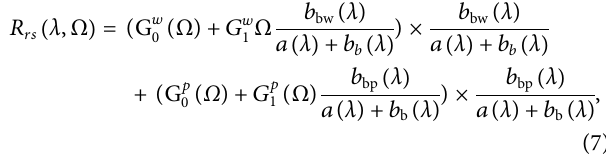
Frontiers in Environmental Science |